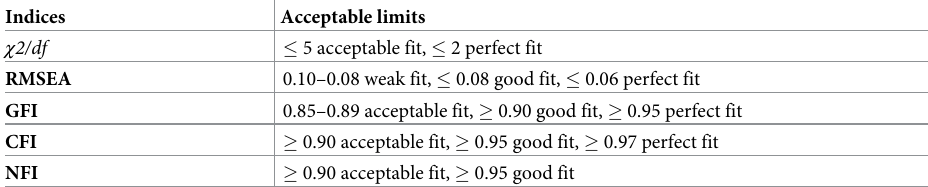
Table 2. Goodness of fit indices and acceptable limits. Indices